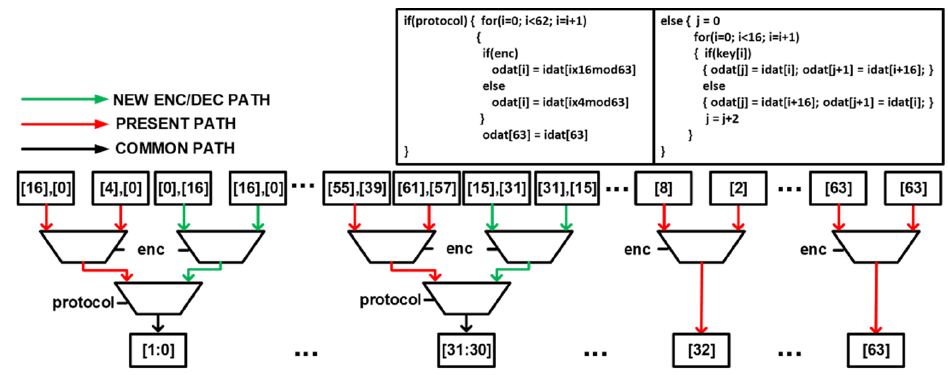
Figure 15. Proposed hardware architecture for 64-bit Unified P-BOX.